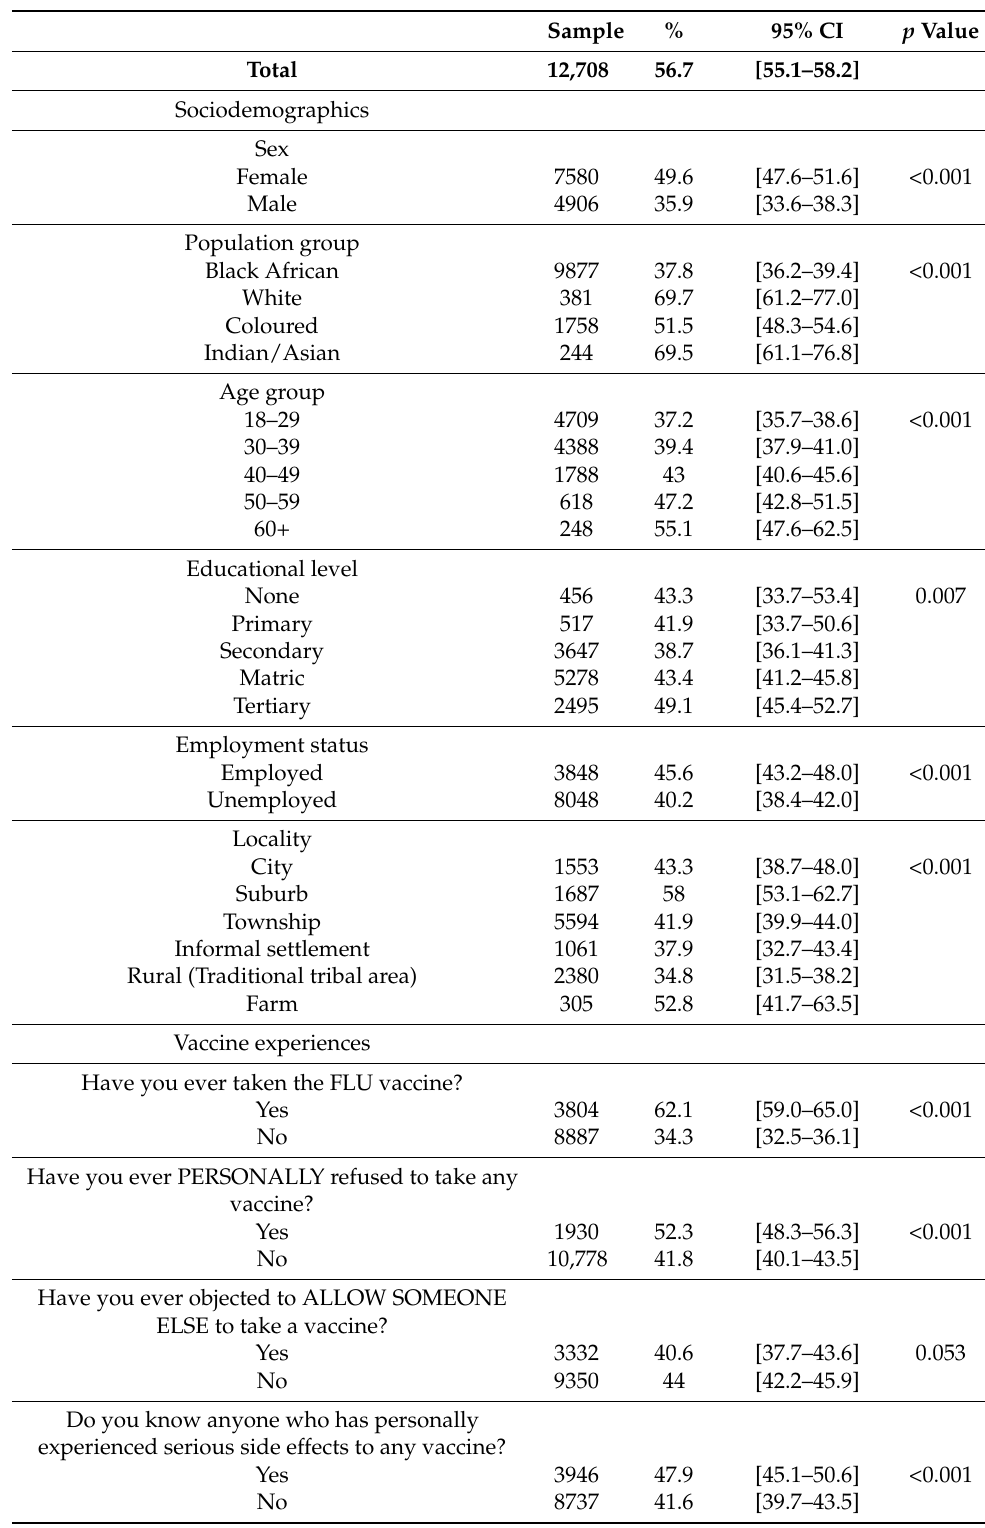
Table 3. Parents’ taking children for scheduled vaccination by sociodemographics, experiences, and